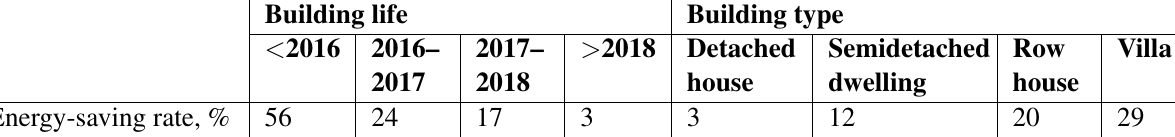
Table 2 Energy-saving potential after residential renovation of different years and types of